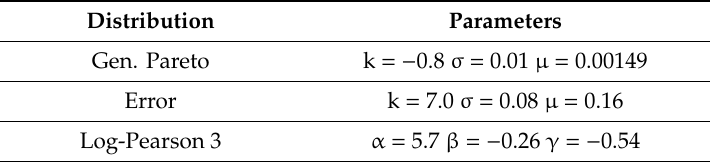
for IBP with T cl = 4 d 0